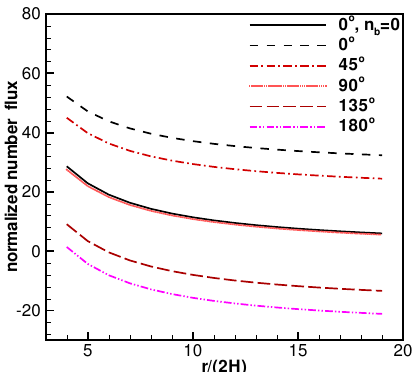
Figure 13. Illustration for different number flux across different curves.